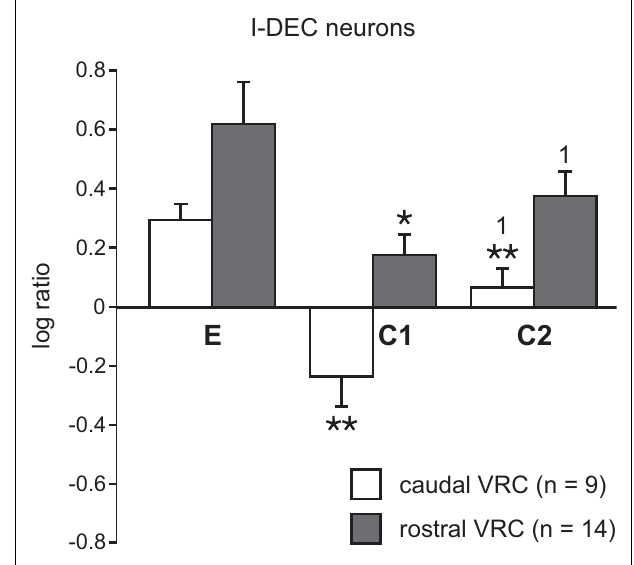
FIGURE 4 |Average log ratios of I-Dec neurons in the cVRC and rVRC. The first (C1) and second (C2) cough cycles from all repetitive cough episodes were analyzed. *, Significantly different from E; 1, significantly different from C1. P -values are indicated by one ( p < 0.02) or two ( p < 0.001) symbols. Error bars indicate the standard error of the